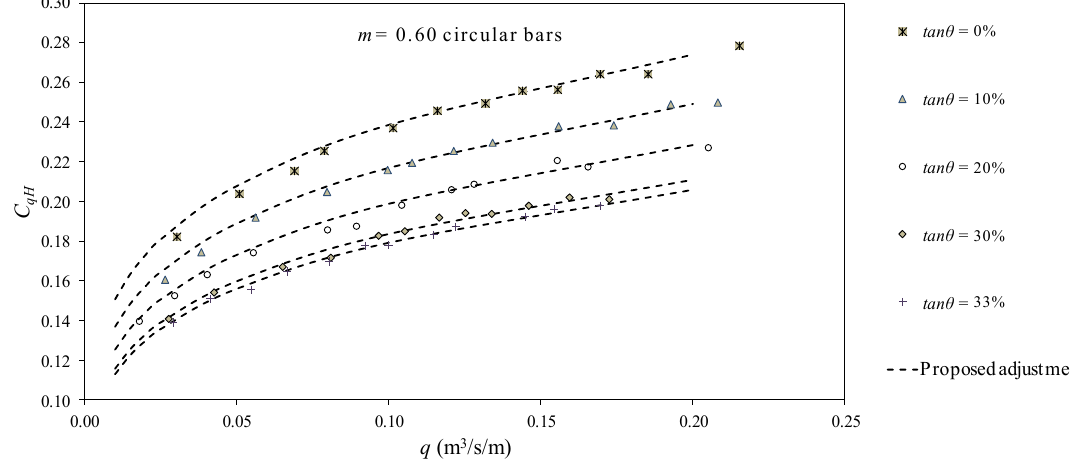
Figure 21. Mean discharge coefficient C qH as a function of the incoming flow q , for circular bars with void ratio m = 0.60.